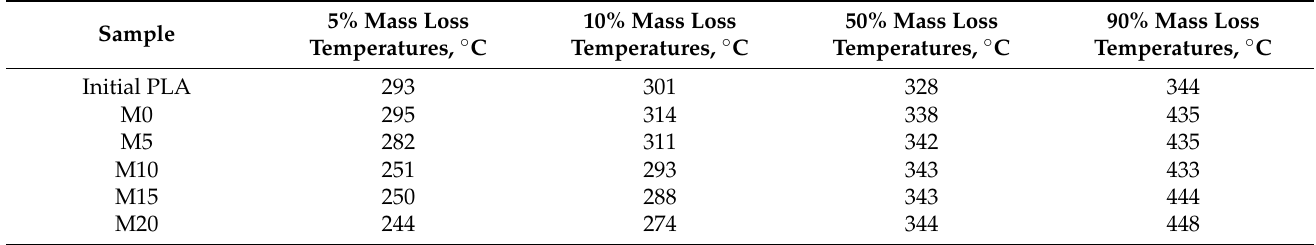
Figure 3. The samples’ DTG curves. Table 2. The TGA